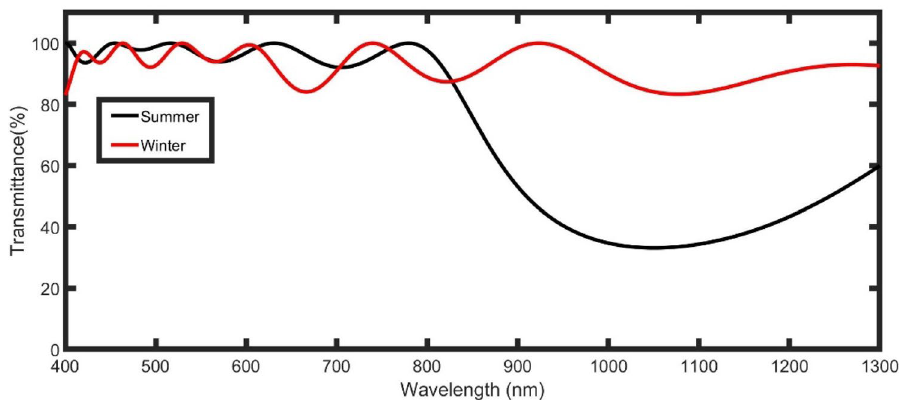
Figure 2. The transmittance of the proposed smart windows for TE polarized light at initial